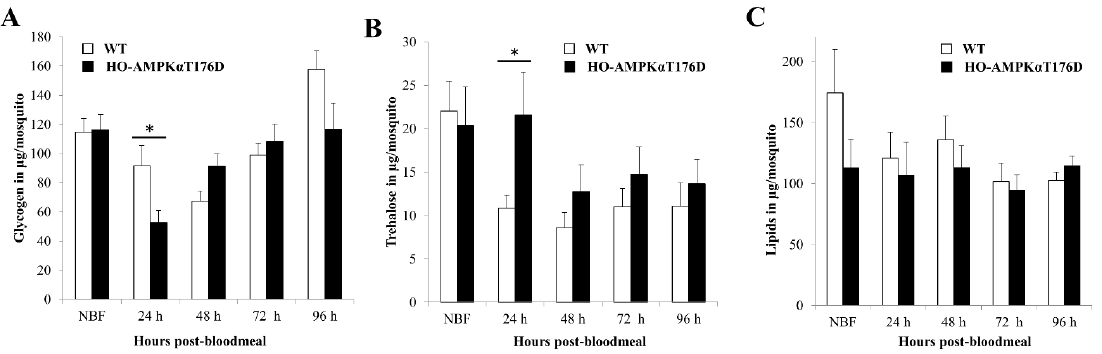
Figure 3. Effect of HA-AMPK α T176D overexpression on An. stephensi glycogen, lipids, and trehalose. ( A ) Glycogen ( B ) Trehalose, and ( C ) Lipids were extracted and assayed from pools of five females. Average concentrations ± SEMs are shown. Data were analyzed using Student’s t test ( n = 15 biological replicates). * p < 0.05 relative to wild type controls.